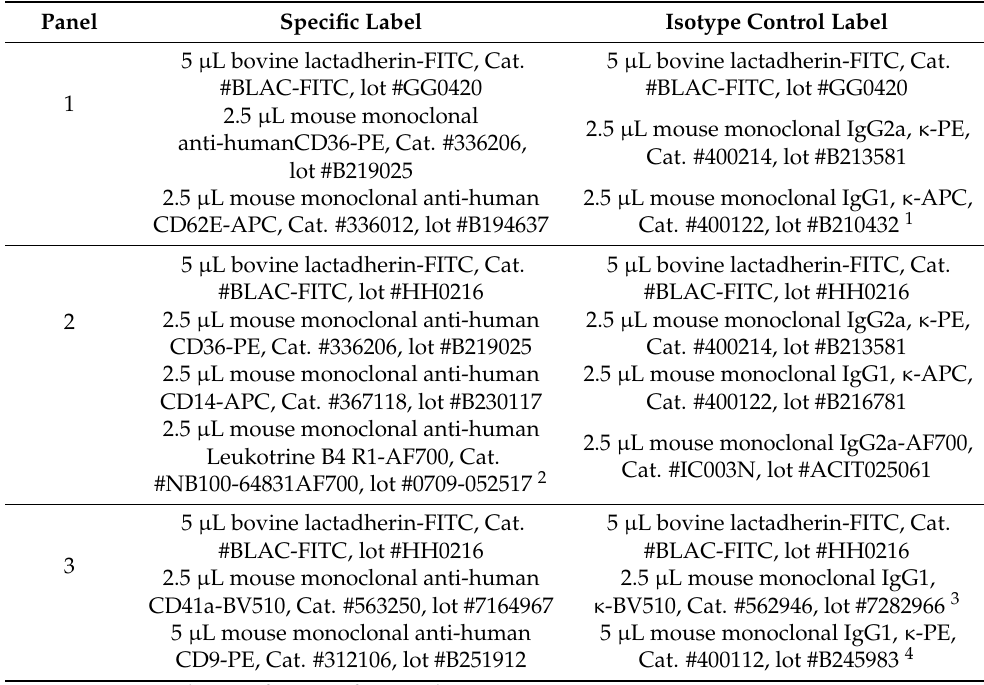
Table 1. Labels used in this